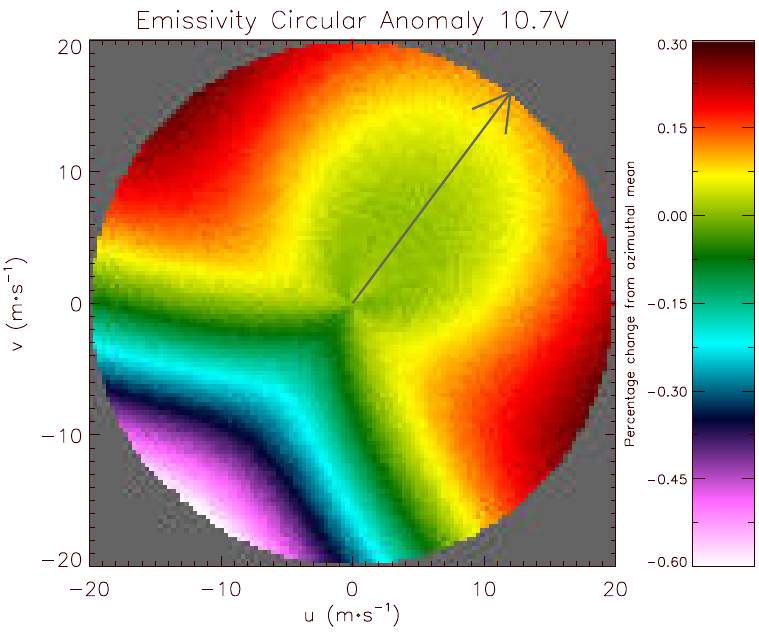
Figure 3. Deviation of emissivity from the azimuthal mean as a function of wind speed components. The lack of symmetry implies that the observation contains some information about the individual wind-speed components. The satellite azimuth angle has been chosen to be 37 ◦ here and is indicated by the arrow. A value of 0 ◦ would align the pattern along the v